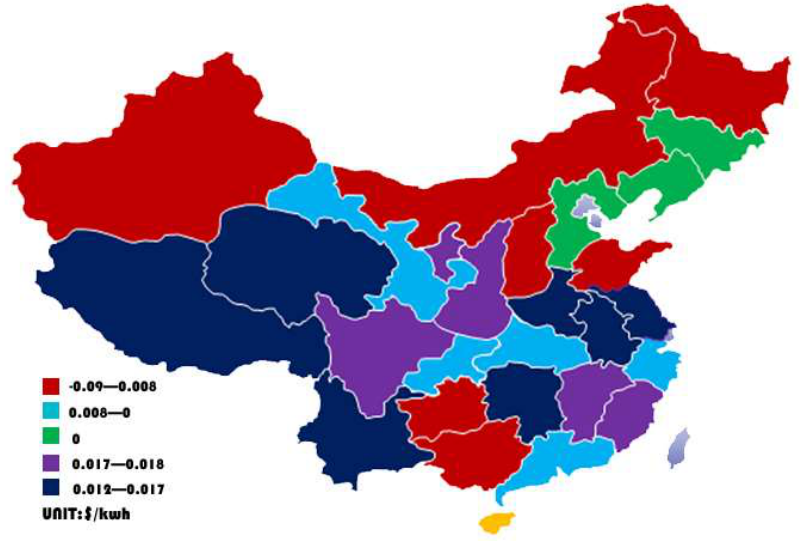
Figure 22. The difference between commercial electricity price and LCOE in China.